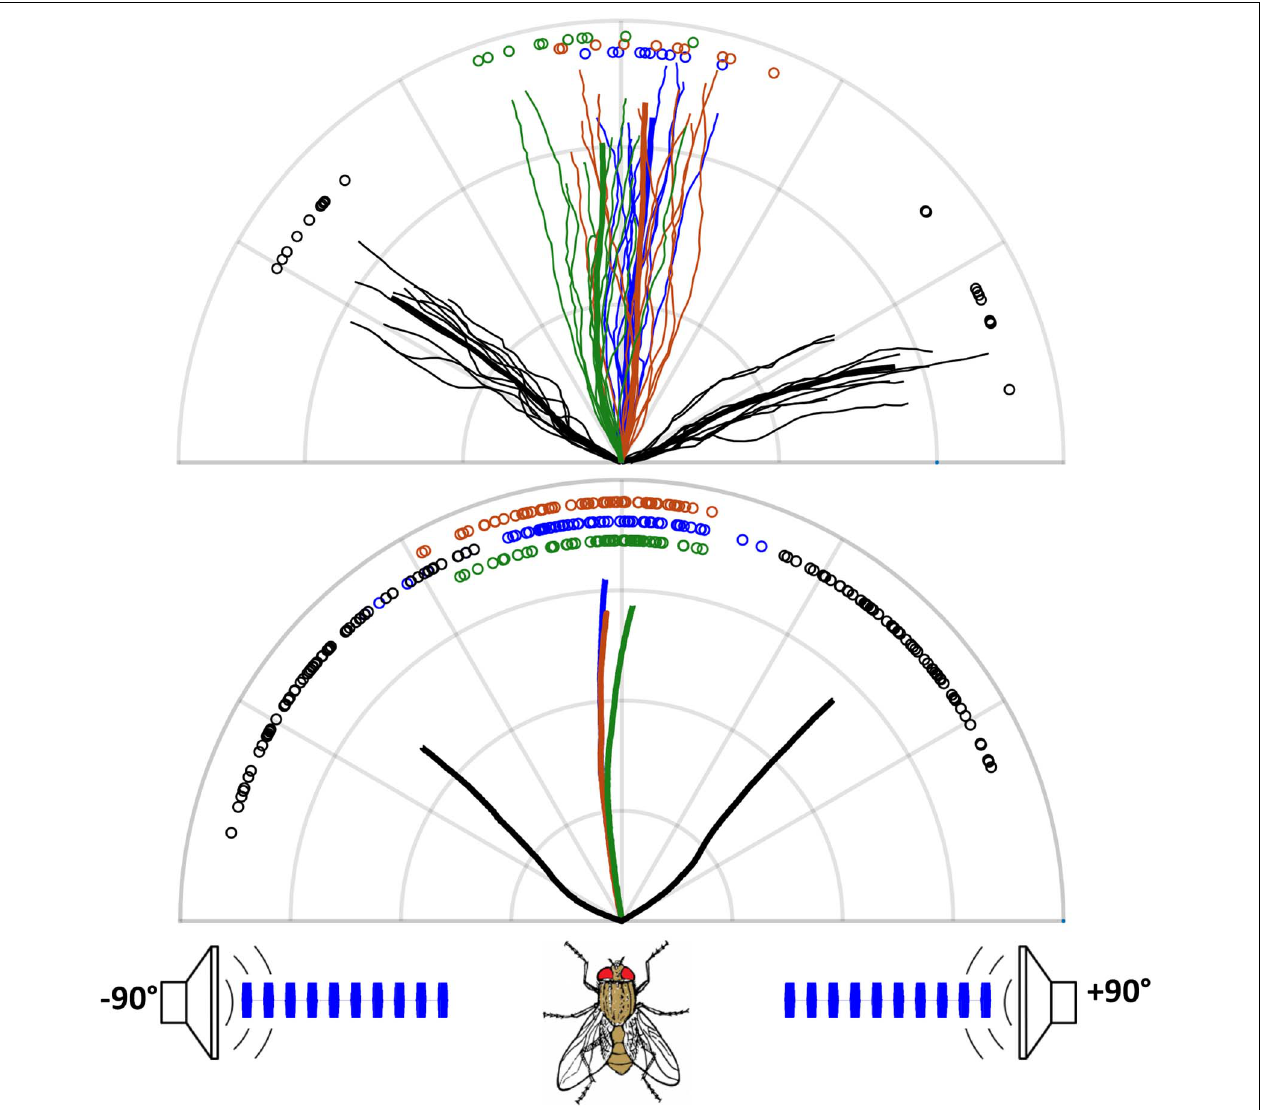
FIGURE 4 | Phonotactic walking responses for standing wave stimuli. The upper panel shows data for a single fly (grid = 5 cm). Thick lines represent averages (10 runs per trace); fine lines show the corresponding individual responses. Symbols (here and in subsequent figures) show the angles of the individual responses measured at the halfway point of each walking path, and statistical comparisons were based on these angles. The lower panel shows pooled responses for six flies (10 runs per fly in each trace, grid = 2 cm). Black traces are responses to stimuli from single speakers on the corresponding side of the fly. The green traces show responses to both speakers broadcasting in-phase stimuli (symmetric tympanal vibration simulates a single source at 0 ◦ ). The blue and red traces show responses to both speakers broadcasting opposite-phase stimuli adjusted to create a standing wave (anti-symmetric vibration, for equal-amplitude but out-of-phase tympanal vibration), with blue and red traces representing opposite-phase standing waves. The flies’ responses were not affected by the phase of the standing wave (single fly – Watson’s U = 0.093, p > 0.1; pooled data – Watson’s U = 0.0416, p > 0.1, n = 6). Responses to these conditions are similar to a forward source and show no directional response to cycle-by-cycle phase differences in the stimulus waveform as a cue for directionality (single fly – Rao’s homogeneity test for vector direction = 1.55916, p > 0.4; pooled data – Friedman chi-squared = 3.0333, df = 2, p >